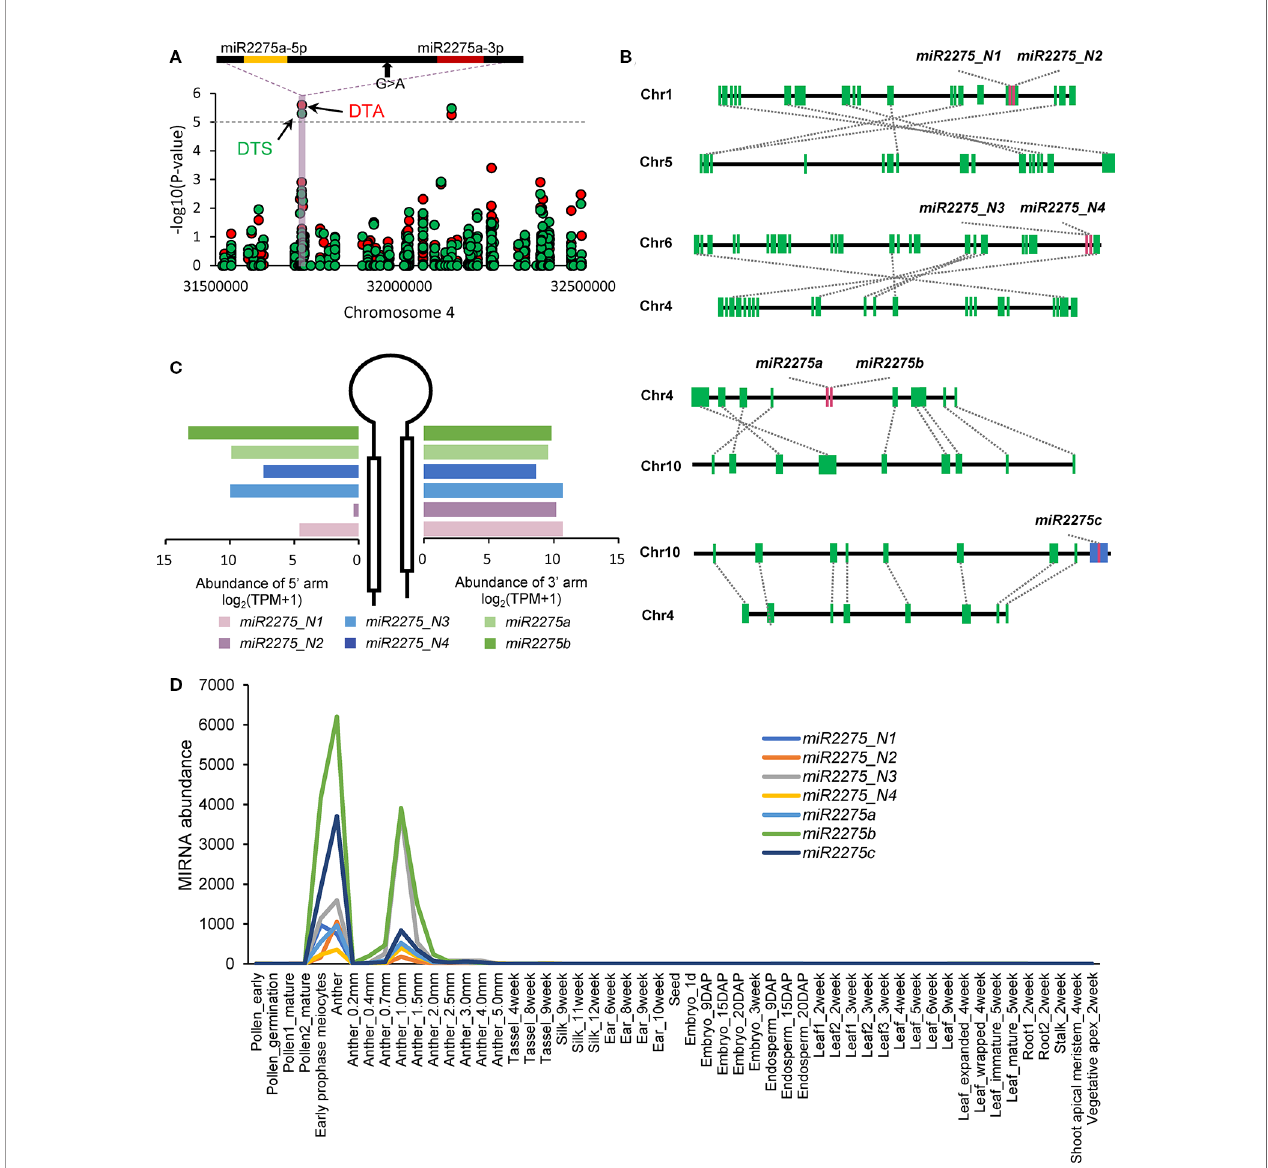
FIGURE 5 | Evolutionary consequence of the miR2275 family in maize. (A) GWAS results, which overlapped with miR2275 loci. The gray horizontal dashed lines indicate the signi fi cance threshold of GWAS (1 × 10 − 5 ). The mature miRNA sequences are highlighted in red and the miRNA star sequences are highlighted in yellow. Black arrows indicate signi fi cant mutation sites. Days to anthesis (DTA) and days to silk production (DTS) are labeled in red and green, respectively. (B) Duplication status of miR2275 family members. Green boxes indicate PCGs, red boxes represent miR2275 gene family members, and the blue box represents helitron transposon. (C) Comparison of mature miRNA accumulation between 5 ′ and 3 ′ arms in individual miR2275 members. (D) Accumulation levels of seven miR2275 genes in individual tissue samples. The accumulation levels were calculated as sum of miRNA mature sequences, miRNA star sequences and